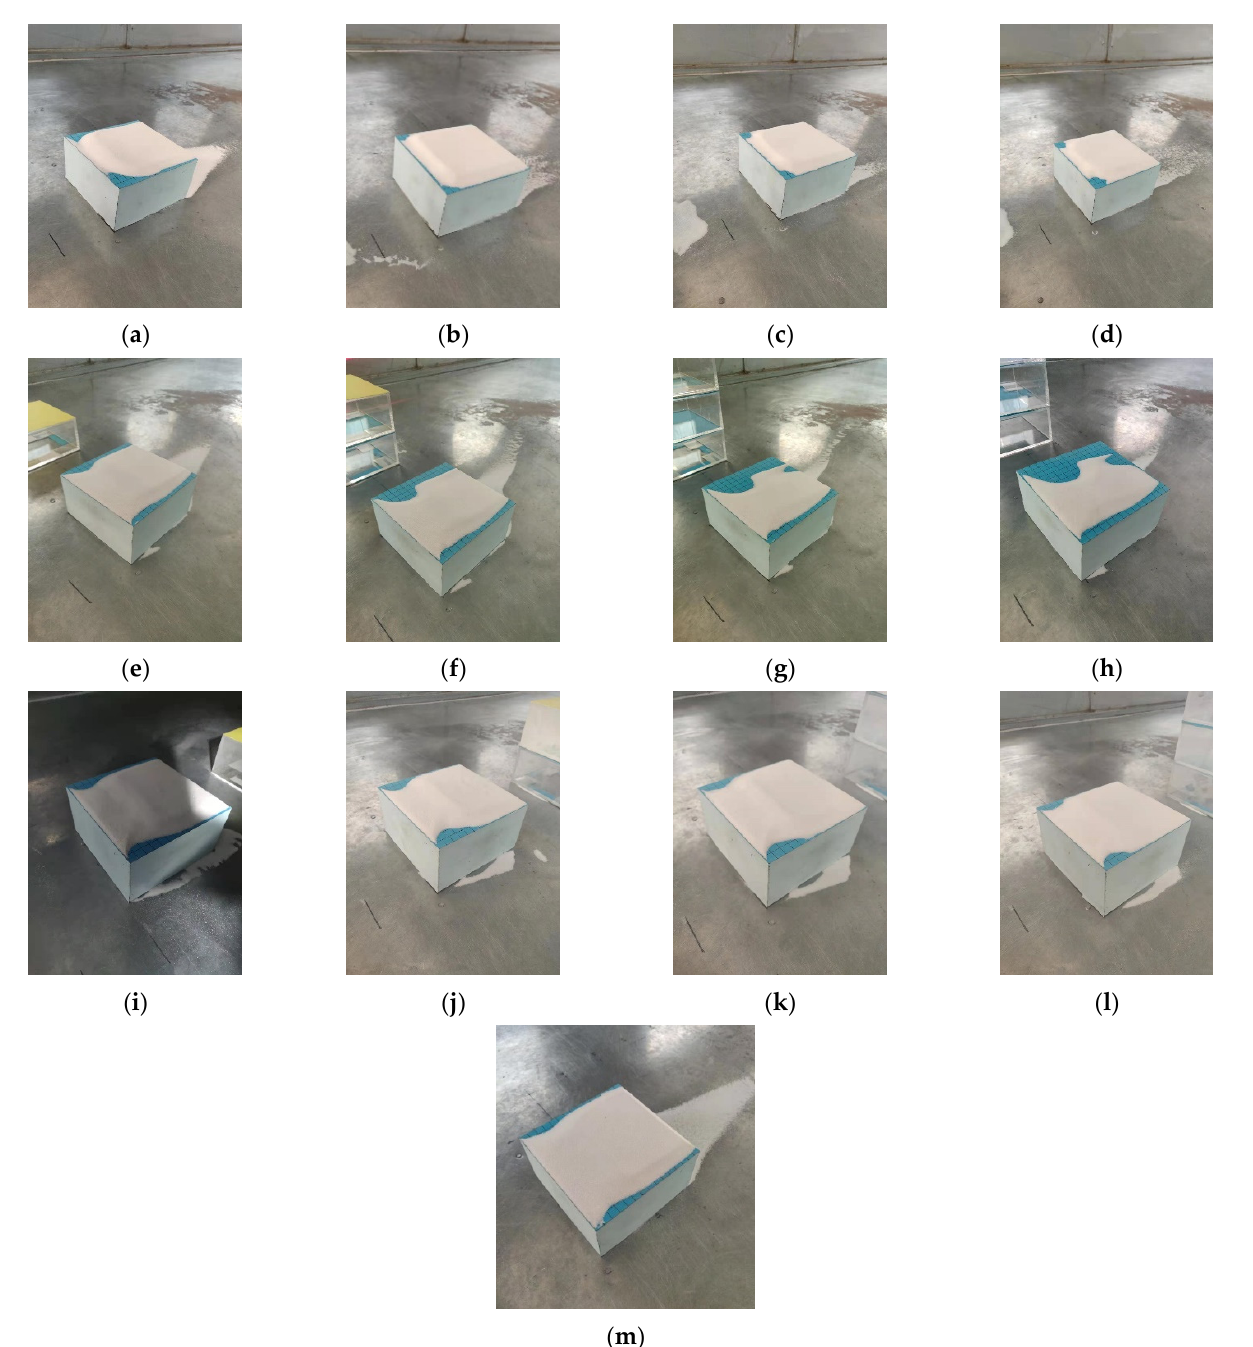
Figure 4. Photos of typical cases: ( a ) Case: D / H 0 = 2— H / H 0 = 1— WD 0°; ( b ) Case: D / H 0 = 2— H / H 0 = 2— WD 0°; ( c ) Case: